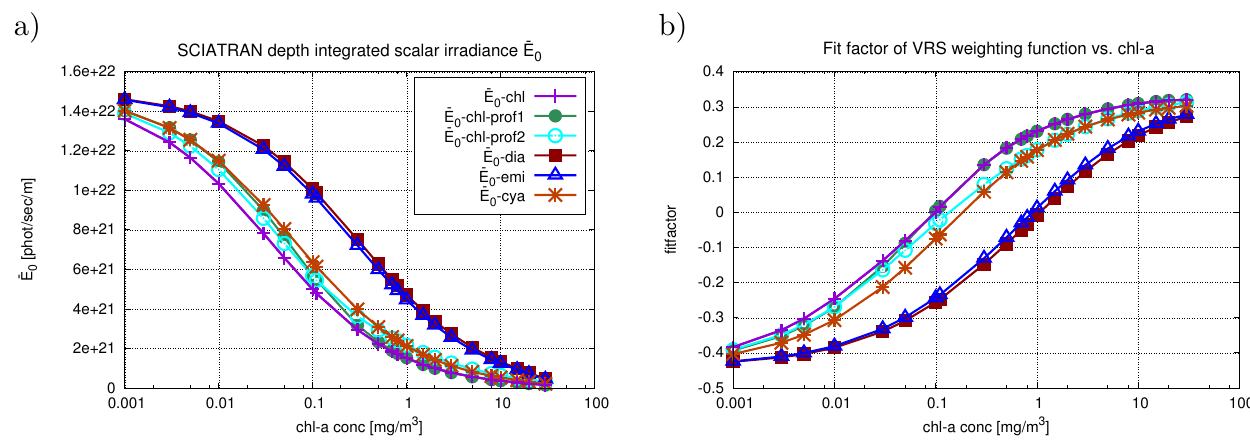
Figure 8. (a) E 0 vs. chl a for different phytoplankton types (using phytoplankton absorption spectra specific for diatoms (dia), cyanobacteria (cya) and coccolithophores (emi) taken from Bracher et al. (2009) and Sadeghi et al. (2012), respectively) and profiles (profile-1 for a stratified and profile-2 for a mixed water profile according to Uitz et al. (2006)). (b) VRS fit factor (cid:49)q V vs. chl a for the same scenarios as in (a) .